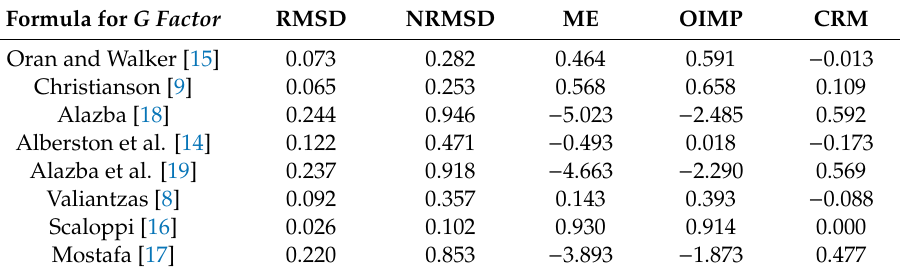
Table 3. The statistical indices for the selected